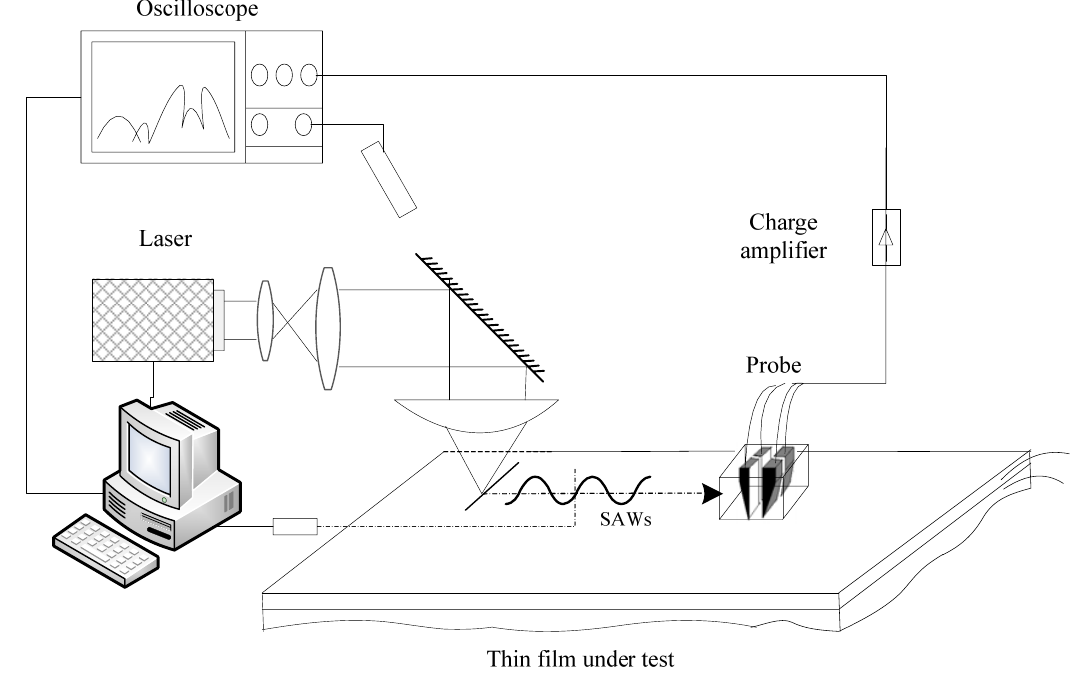
Figure 5. PVDF piezoelectric transducer SAW detection system schematic diagram.